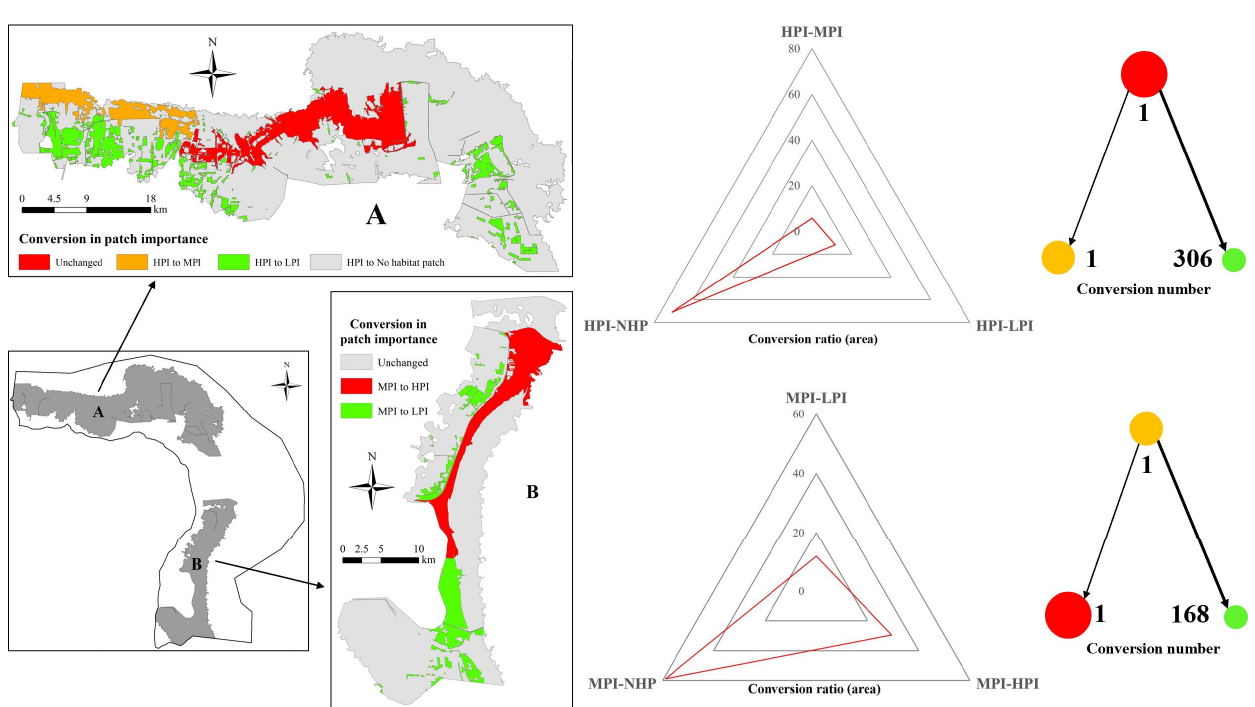
Figure 6. Change in the area and number of patches with high patch importance ( A ) and medium patch importance ( B ) between 1975 and 2020. LPI: Low patch importance, MPI: Medium patch im ‐ portance, HPI: High patch importance, NHP: Non ‐ habitat